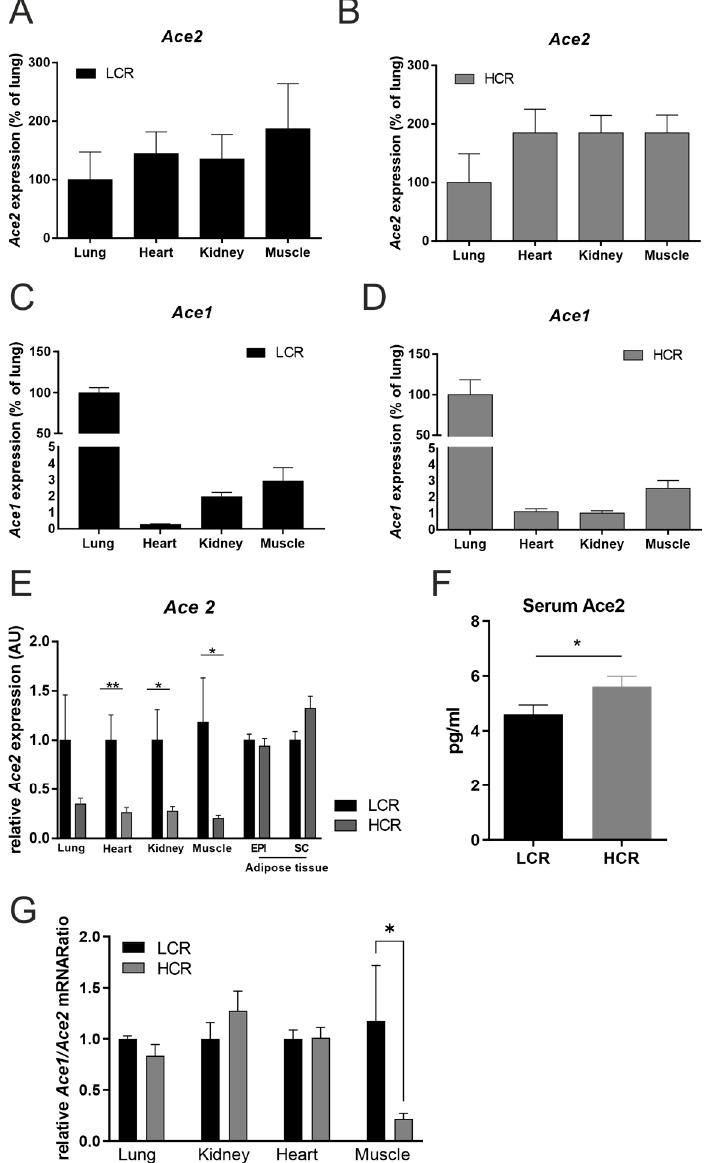
Figure 1. ACE2 and ACE1 mRNA expression in different tissues and ACE2 serum concentration in low- and high-capacity rats. At the age of 19 weeks, 12 rats—either low-capacity runners (LCRs, n = 6) or high-capacity runners (HCRs, n = 6) were investigated. ( A ) Body weight in LCRs versus HCRs; ACE2 expression in lung, heart, kidney, skeletal muscle (Musculus quadriceps femoris) and adipose tissue epigonadal (EPI) as well as subcutaneous (SC) of ( B ) HCR and ( C ) LCR rats. ( D ) ACE1 mRNA expression in lung, heart, kidney, and skeletal muscle of HCRs. ( E ) Comparison of relative ACE2 mRNA expression between LCRs and HCRs in different tissues. ( F ) ACE2 serum concentrations in LCRs and HCRs. ( G ) The ACE1/ACE2 mRNA ratio in different tissues of LCR and HCR rats. Results are expressed as the means ± SE. The different degrees of significance are indicated as follows: *, p < 0.05; **; p < 0.01.